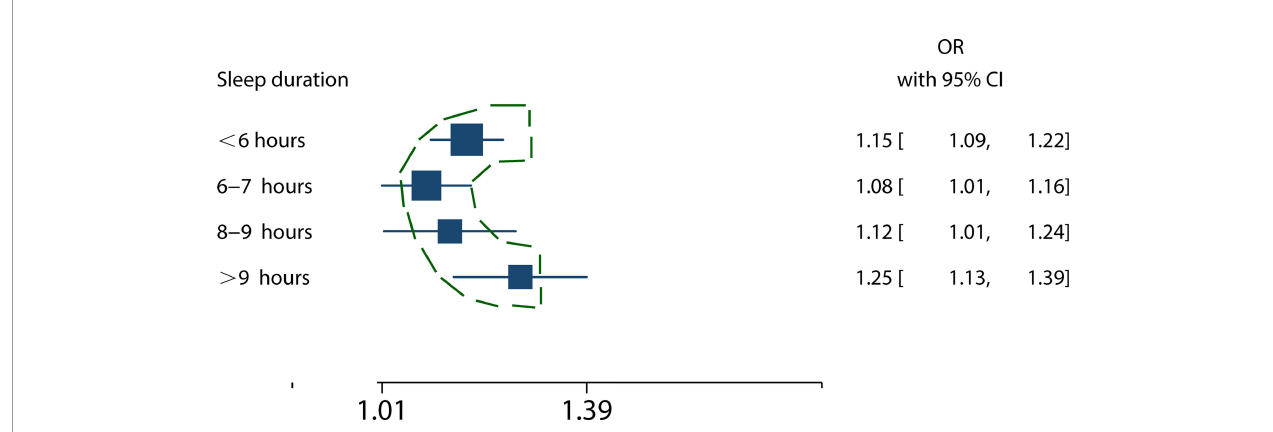
FIGURE 6 | The relationship between sleep duration and MS risk presented a U-shaped curve. The squares represent the mixed RRs of different sleep duration in patients with MS. The broken outline in green illustrates the nonlinear trend, indicating the presence a U-shaped relationship.